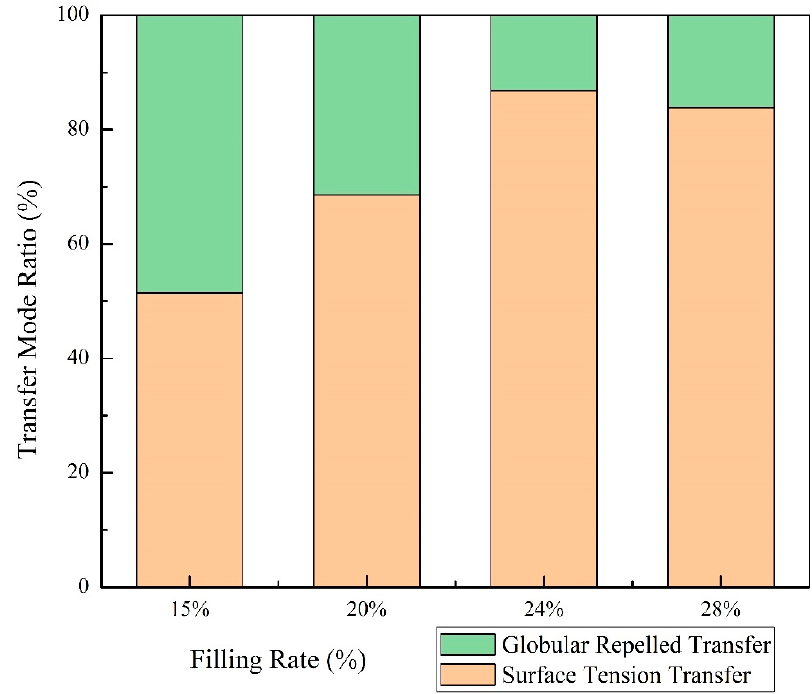
Figure 8. The effect of filling rate on the relative proportion of metal transfer mode.